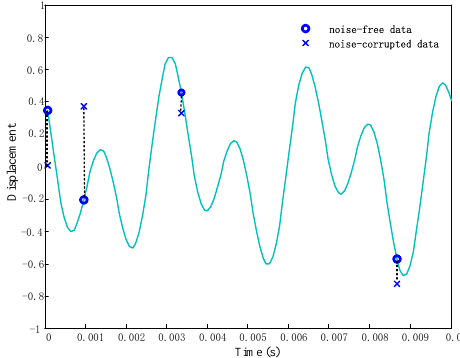
Figure 7. Ideal BTT signals and corrupted signals sampled by four probes in one rotation.